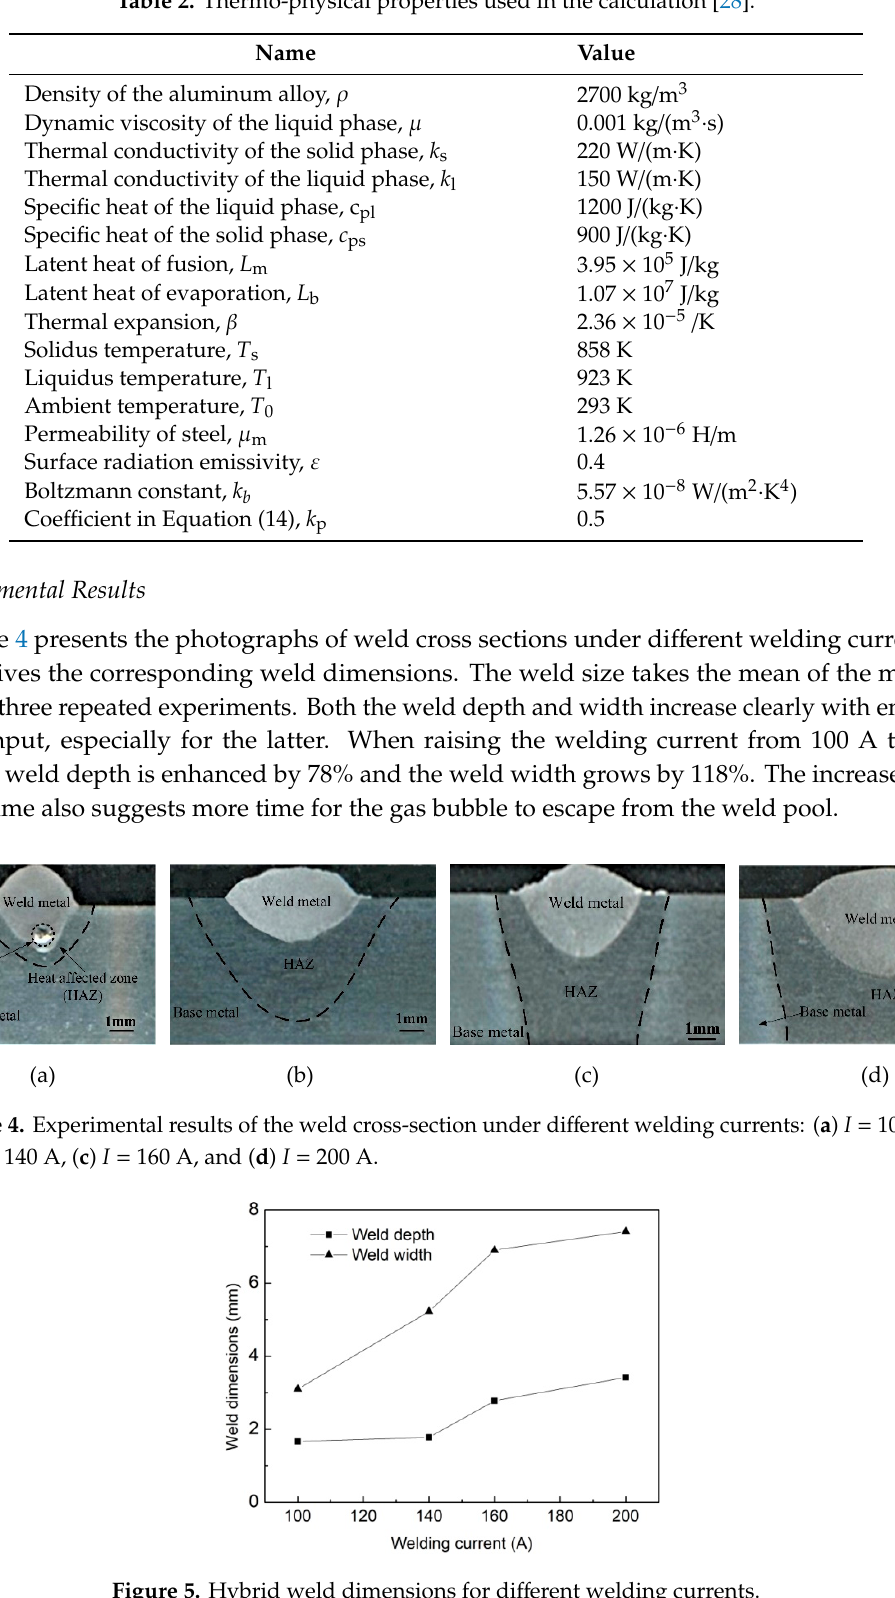
Table 2. Thermo-physical properties used in the calculation [28].